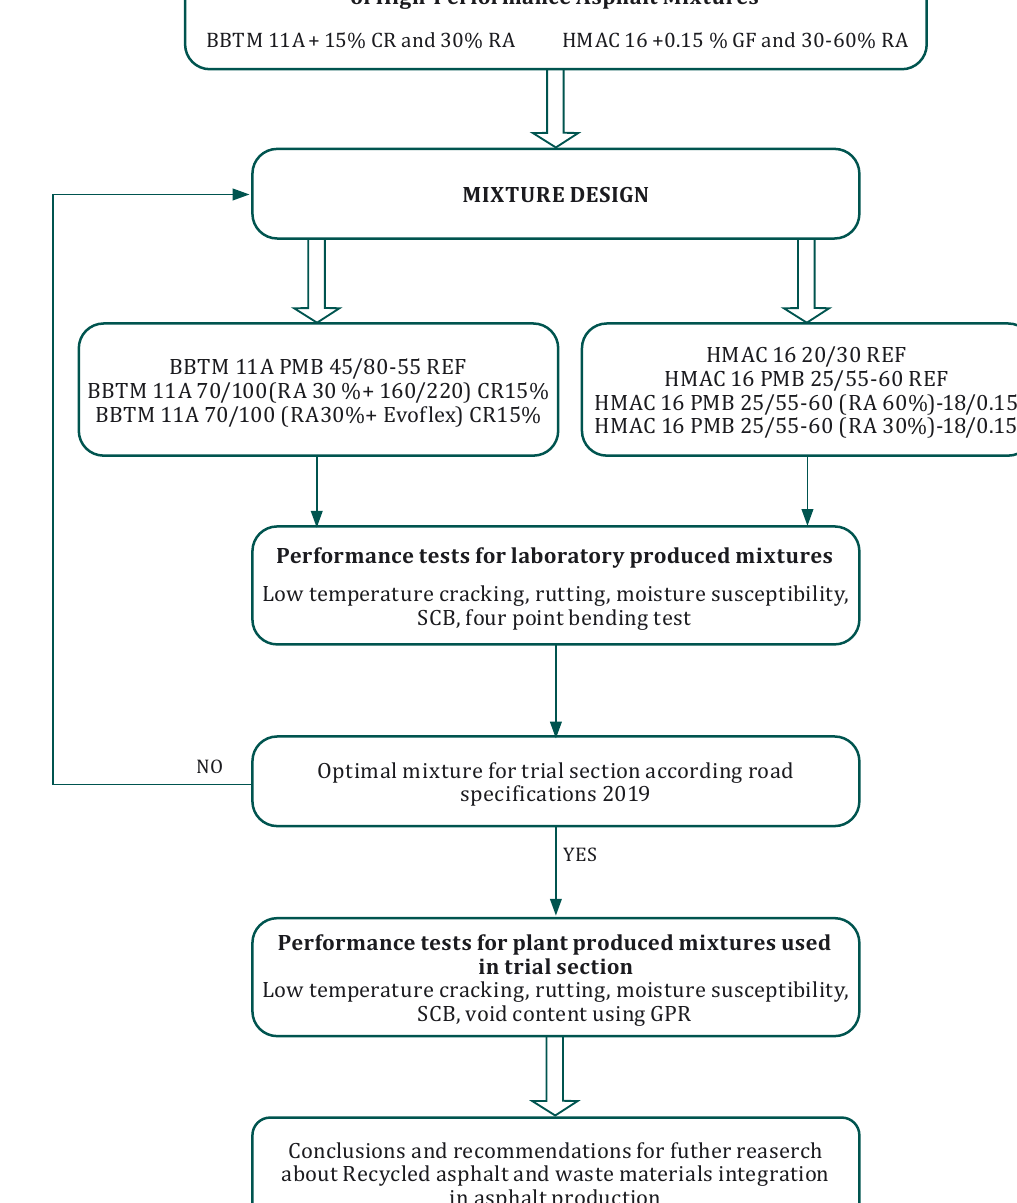
Performance tests for plant produced mixtures used in trial section Low temperature cracking, rutting, moisture susceptibility, SCB, void content using